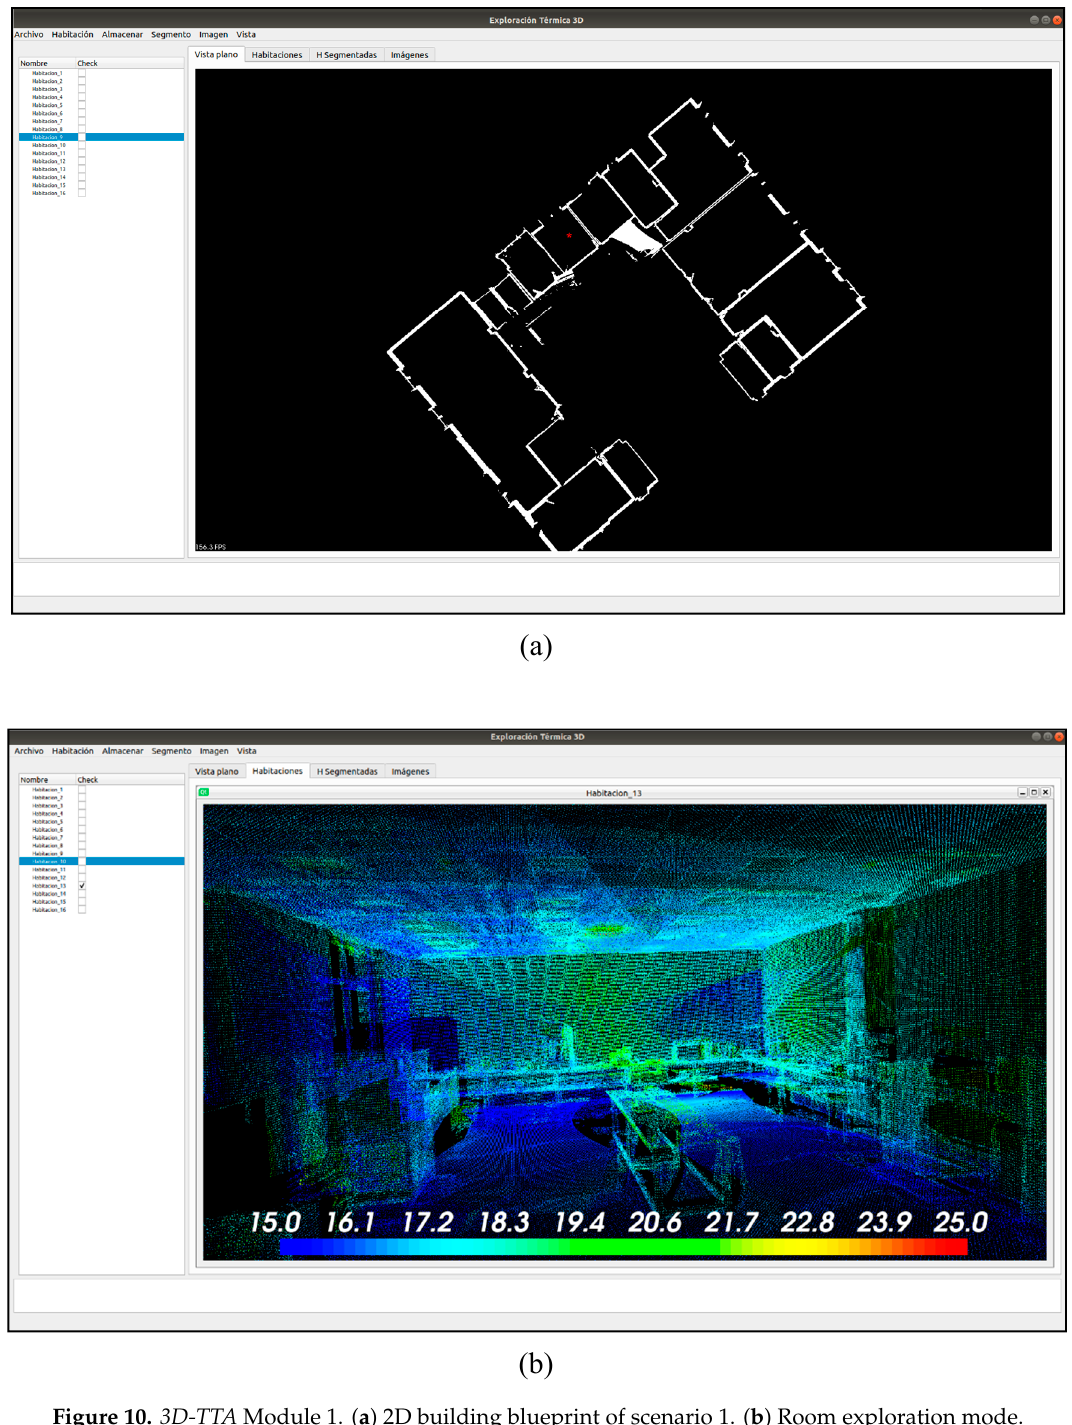
Figure 10. 3D-TTA Module 1. ( a ) 2D building blueprint of scenario 1. ( b ) Room exploration mode.